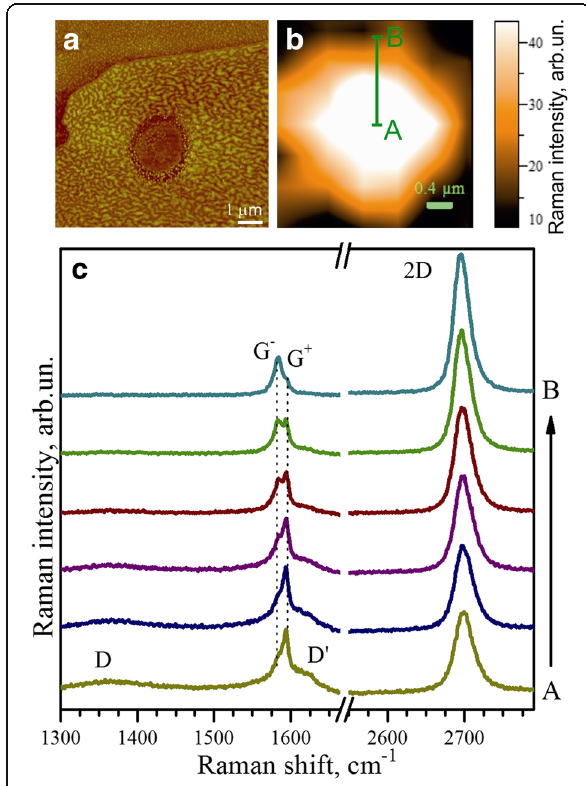
Fig. 7 Confocal Raman mapping. a AFM image of the irradiated graphene area. b Distribution of intensity of the D band in the investigated area. c Set of Raman spectra obtained by scanning along the radius of the irradiated area. Irradiation was performed using 2400 kW/cm 2 laser power and irradiation time of 1